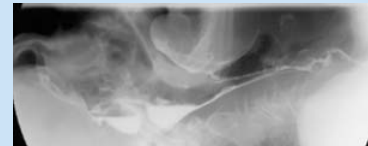
Fig. 2a. Lateral study in the supine position showing contrast in the sphenoidal sinus.